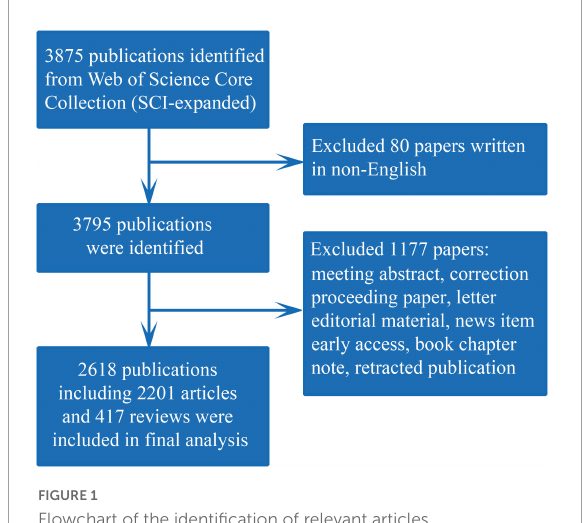
FIGURE1 Flowchart of the identification of relevant